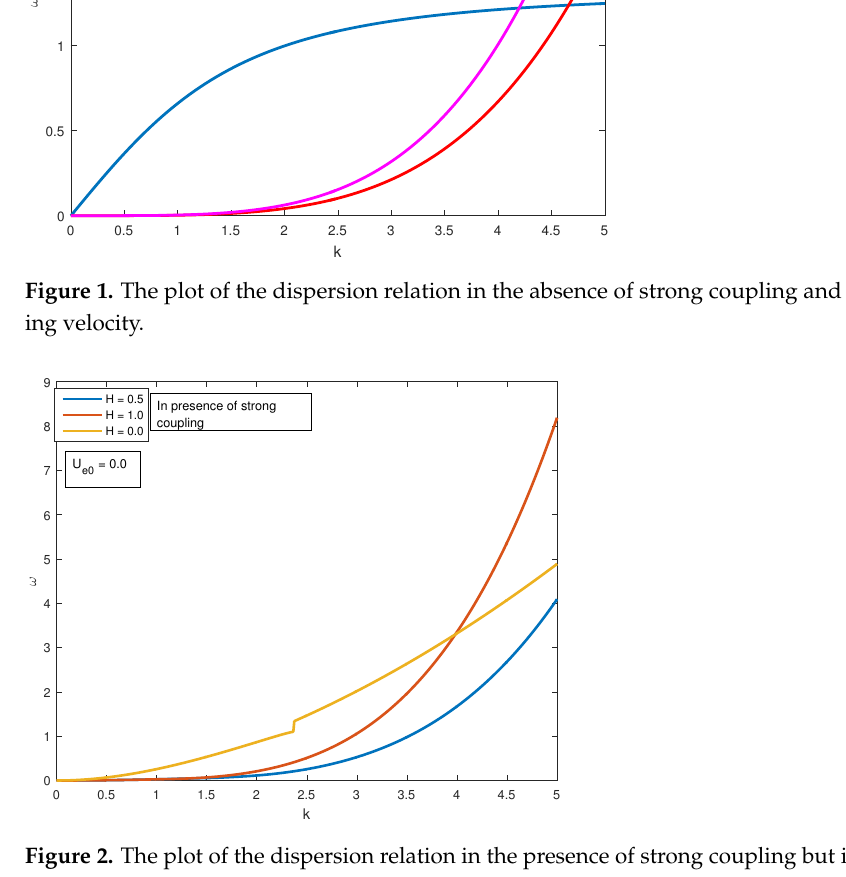
Figure 2. The plot of the dispersion relation in the presence of strong coupling but in the absence of electron streaming velocity.